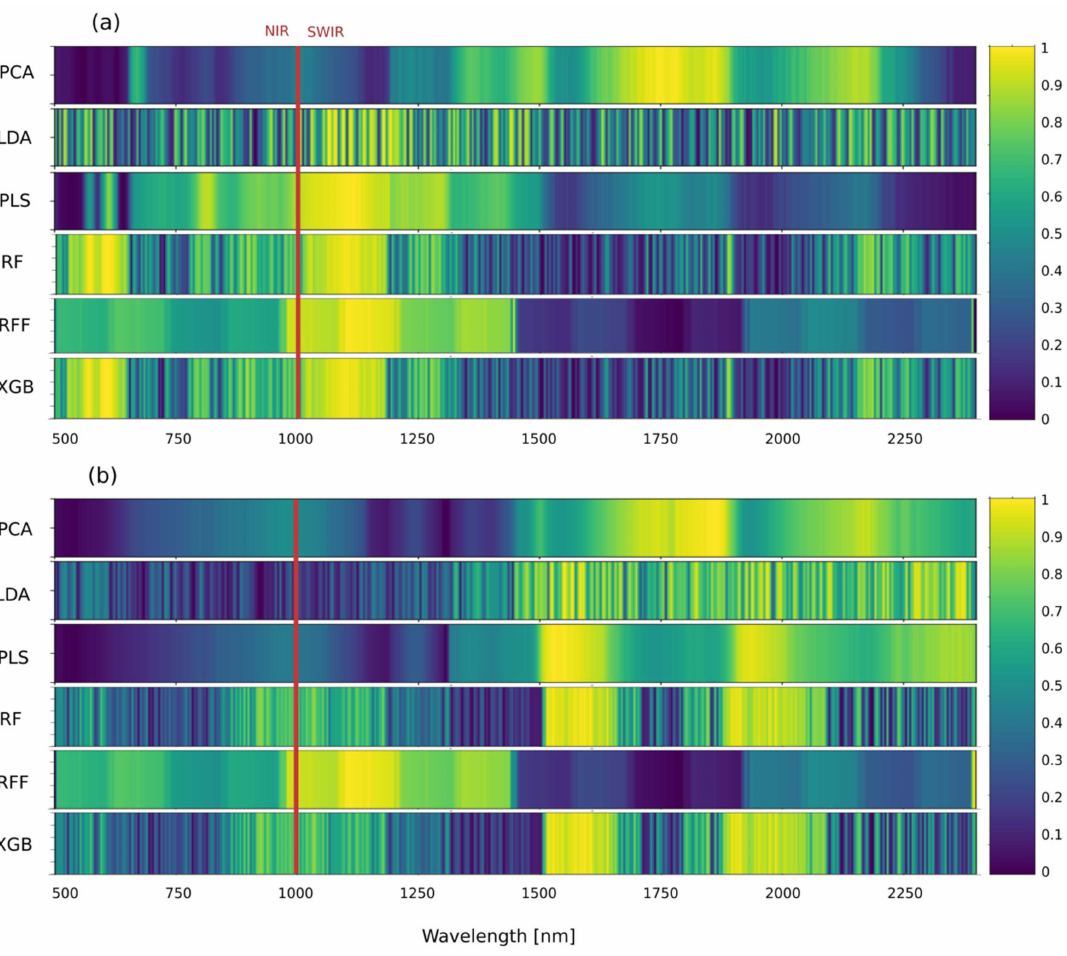
Figure 8. Importance of individual wavelengths, as determined by the different DR methods. ( a ) in- side, and ( b ) outside of potato tuber. Brighter colours represent higher importance. Separation between VNIR and SWIR cameras is marked with red